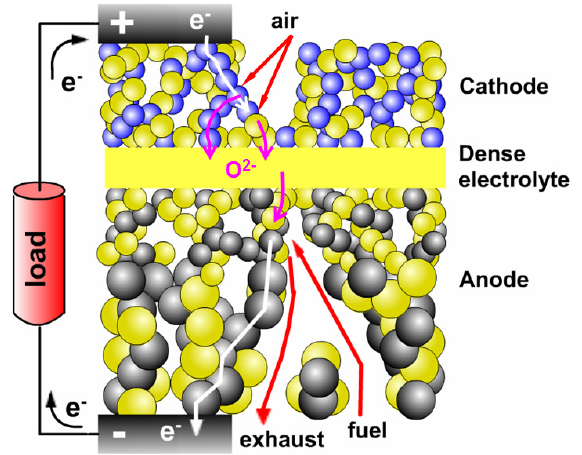
Figure 2. Illustration of the microstructure and physical processes within a single cell. Grey particles for Ni particles within composite anode, yellow particles represent YSZ particles while blue particles represent mixed ion and electron conducting LSCF particles within composite